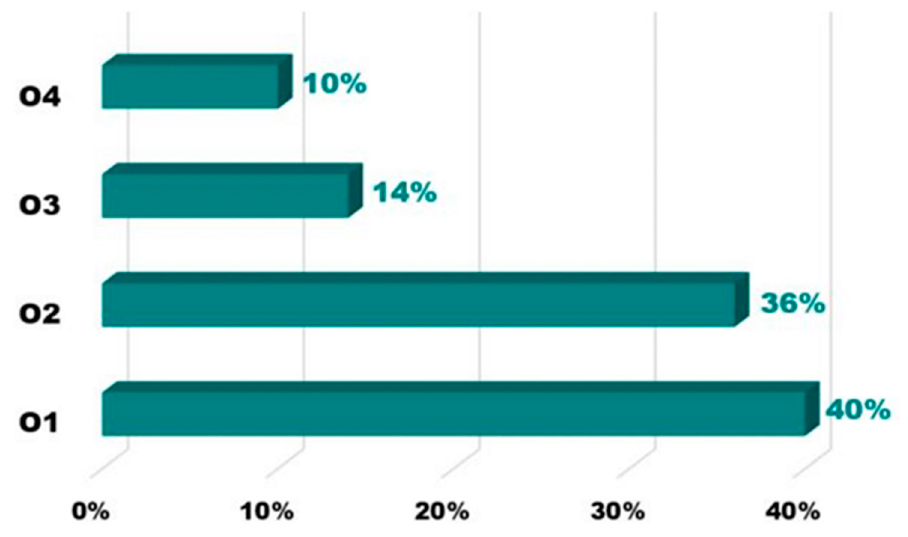
Figure 3. Values of the different pathological origins determined.